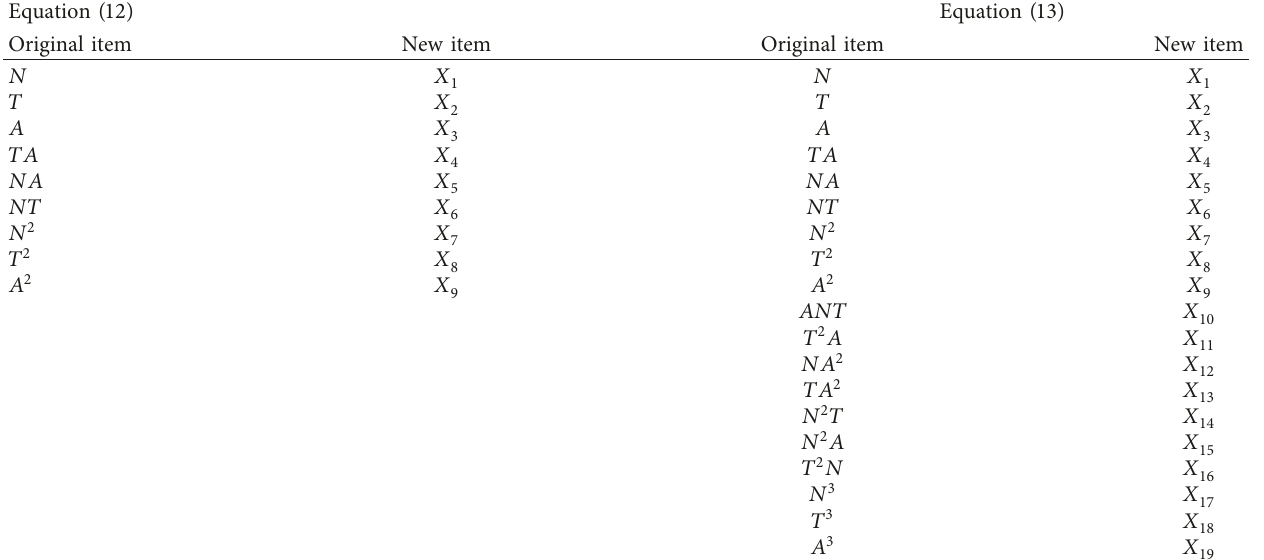
Table 8: Variable substitution.